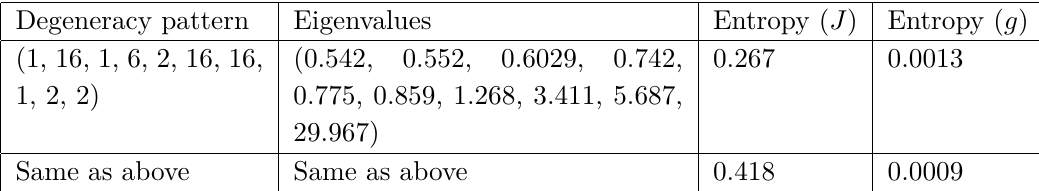
Same as above Table 2 . Partial- skaq solutions for su (8) . The degeneracy pattern found above is quite dominant (238 out of 282) among our su (8) solutions, even though they all refer to different metrics. While the metrics are ideally kaq , their J entropy is in the 1 and 5 percentile in figure